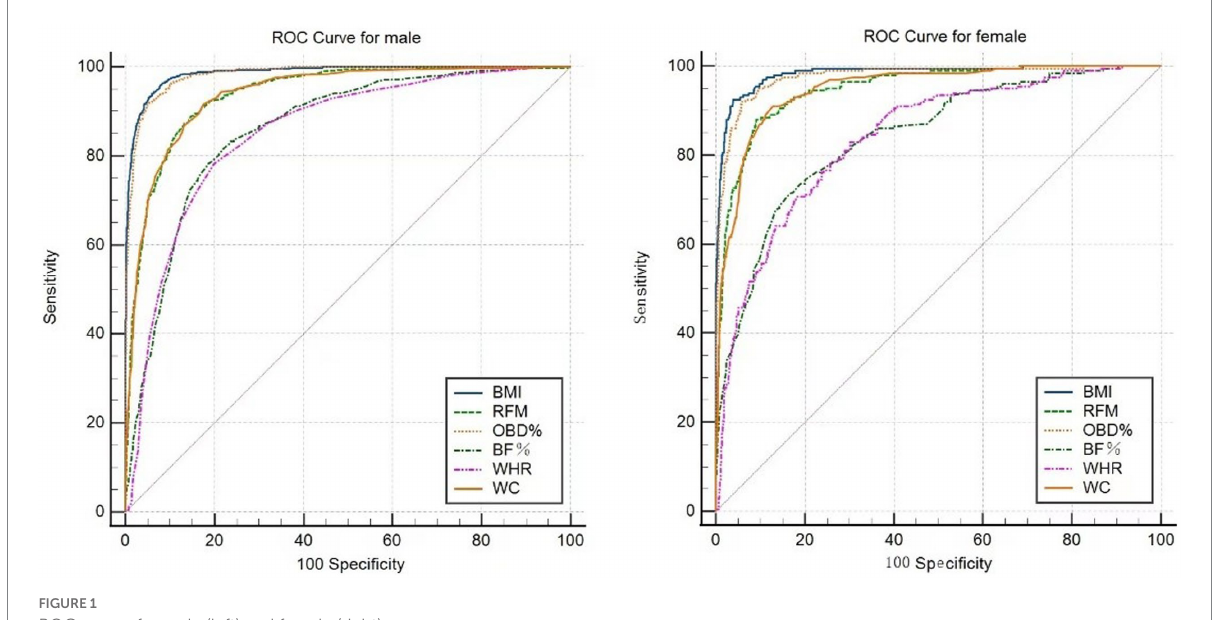
FIGURE 1 ROC curves for male (left) and female